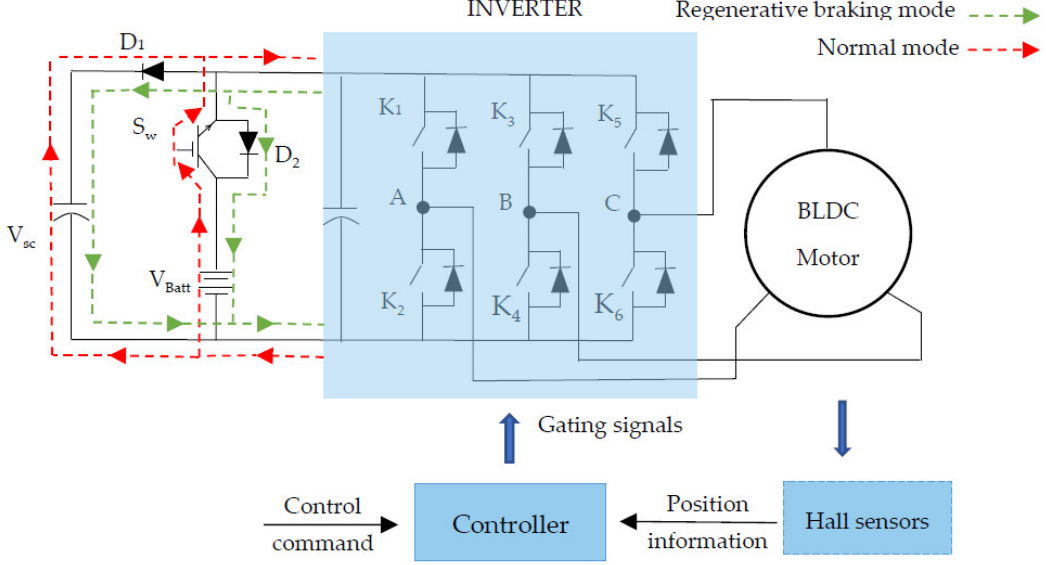
Figure 18. BLDC motor drive system with normal mode and regenerative braking mode.